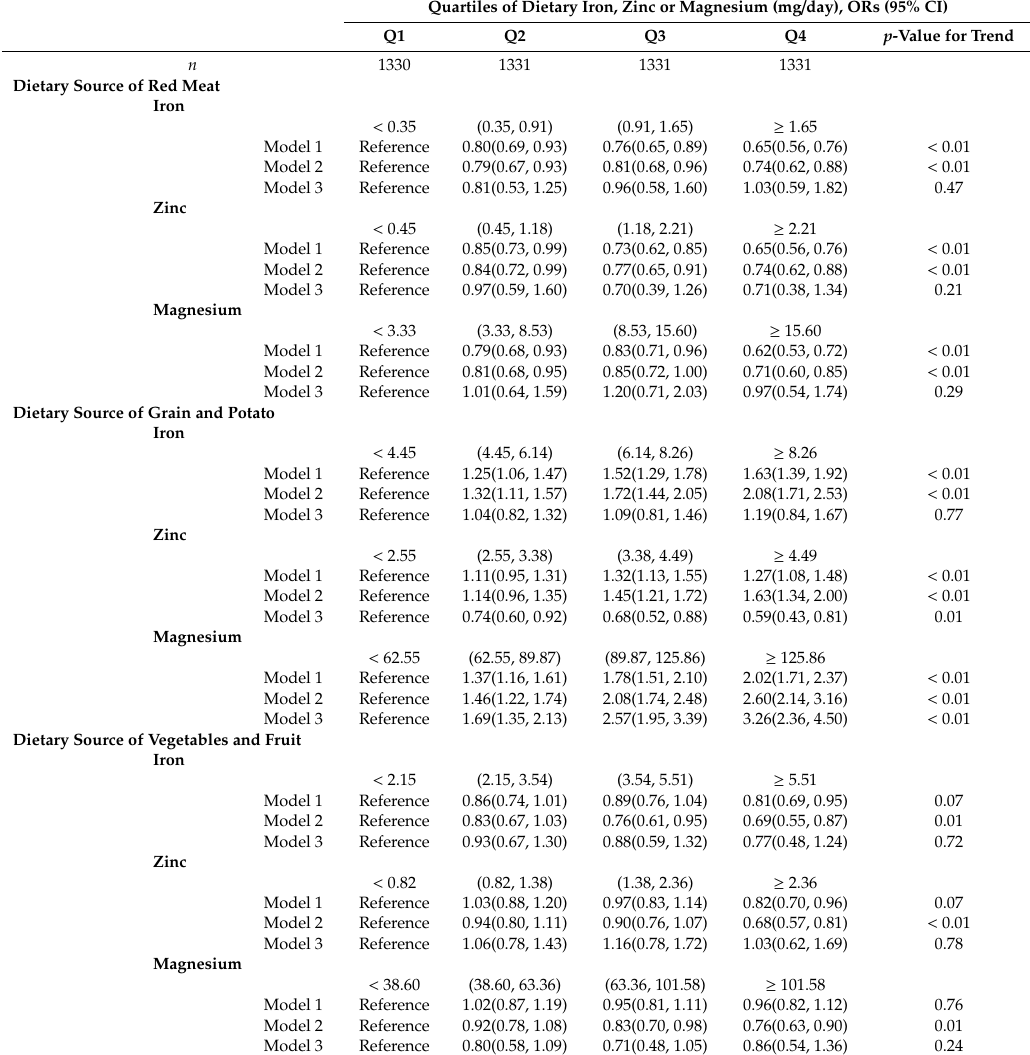
Table 4. ORs (95% CI) for MetS according to the quartiles of dietary iron, zinc and magnesium intakes (mg / day) in 5323 participants from CNHS and SDHS, stratified by food sources 1, 2